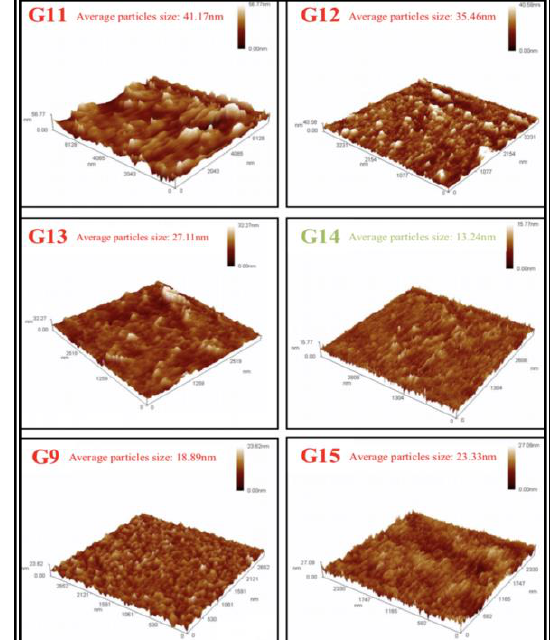
Figure 8. AFM size distribution of gold nanoparticles G3, G6-10